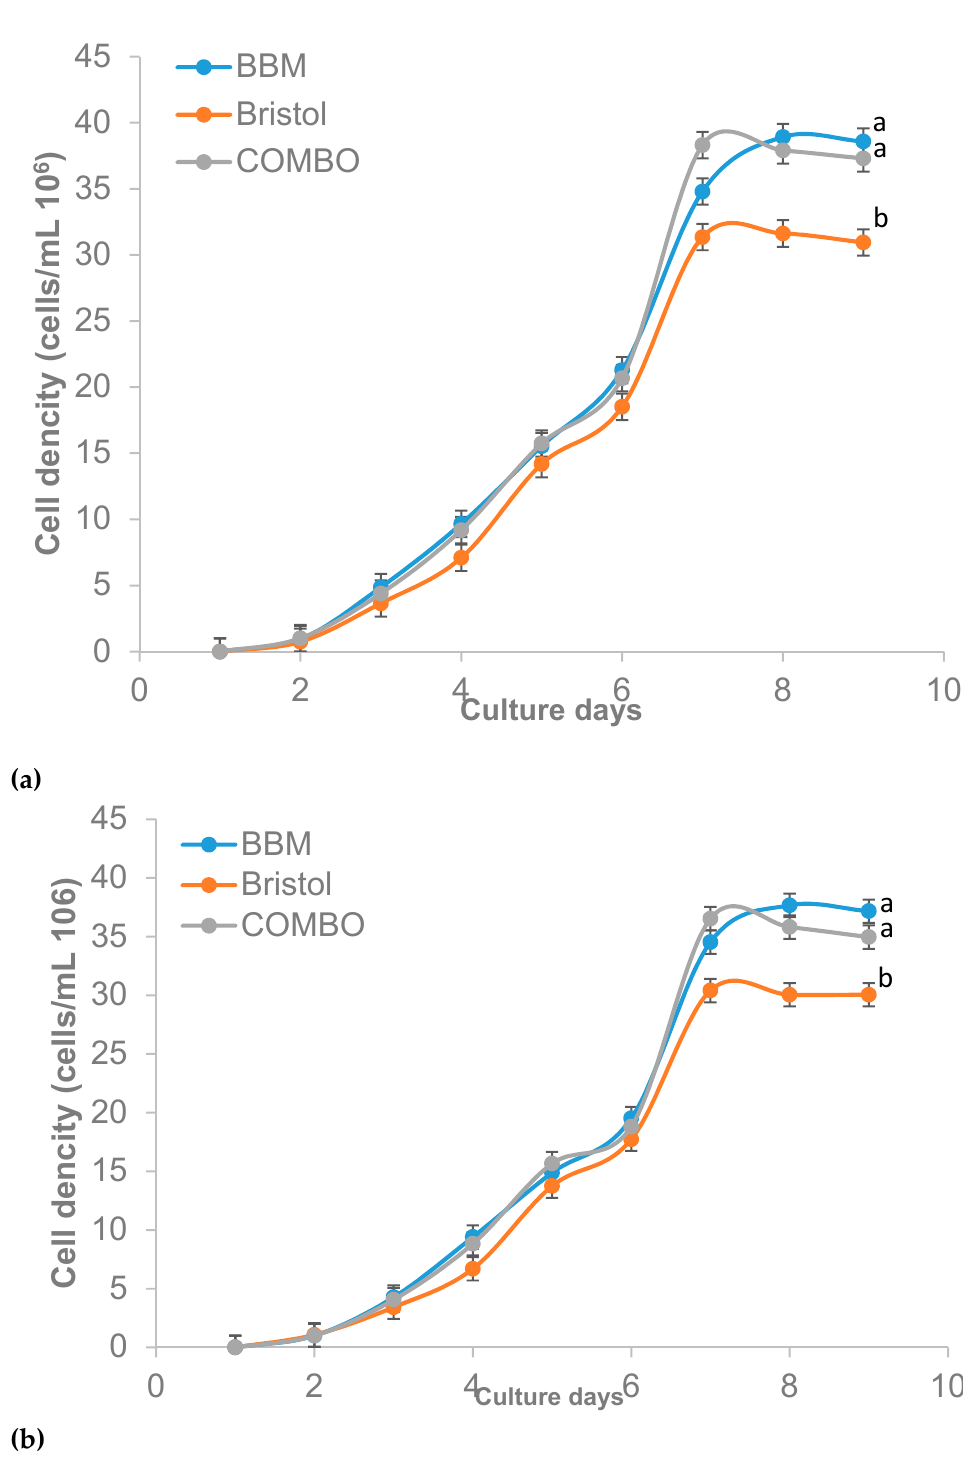
Figure 2. Cell density of Ankistrodesmus falcatus in 100% ( a ) and 50% ( b ) concentration (means ± standard errors). Line with different lowercase letters differs significantly ( p ≤ 0.05).